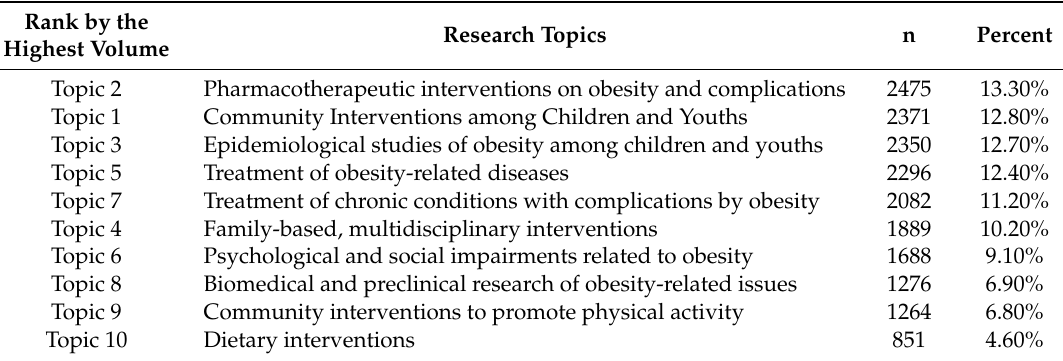
Table 4. The top ten research topics classified using the Latent Dirichlet Allocation method. Rank by the Highest